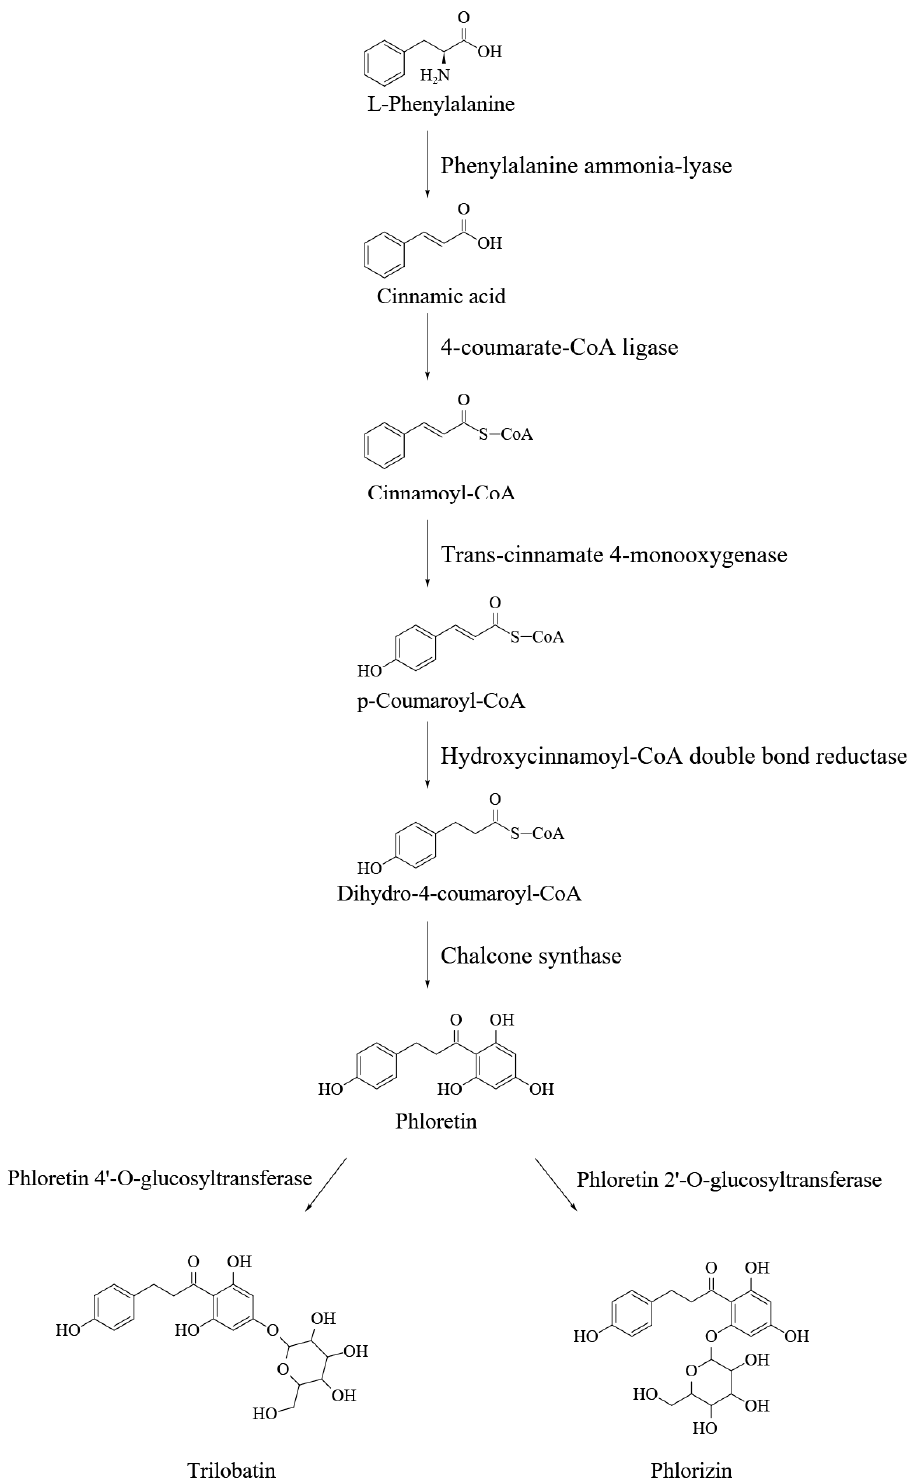
Figure 2. Biosynthesis pathway of the DHCs.